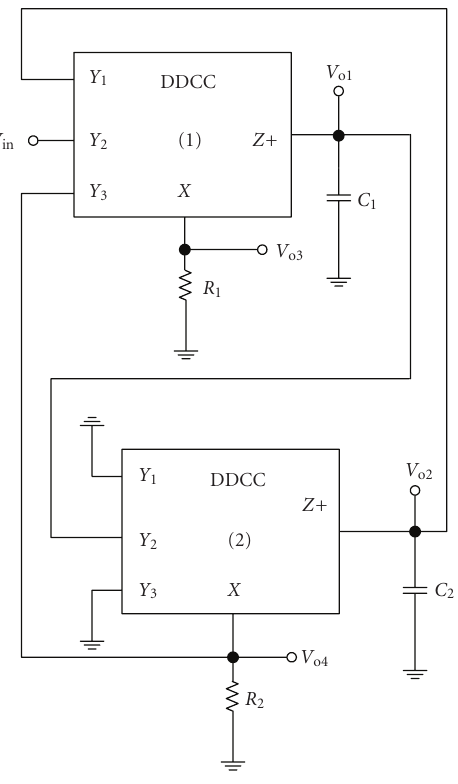
Figure 1: The proposed high-input impedance voltage-mode multifunction biquad based on plus-type